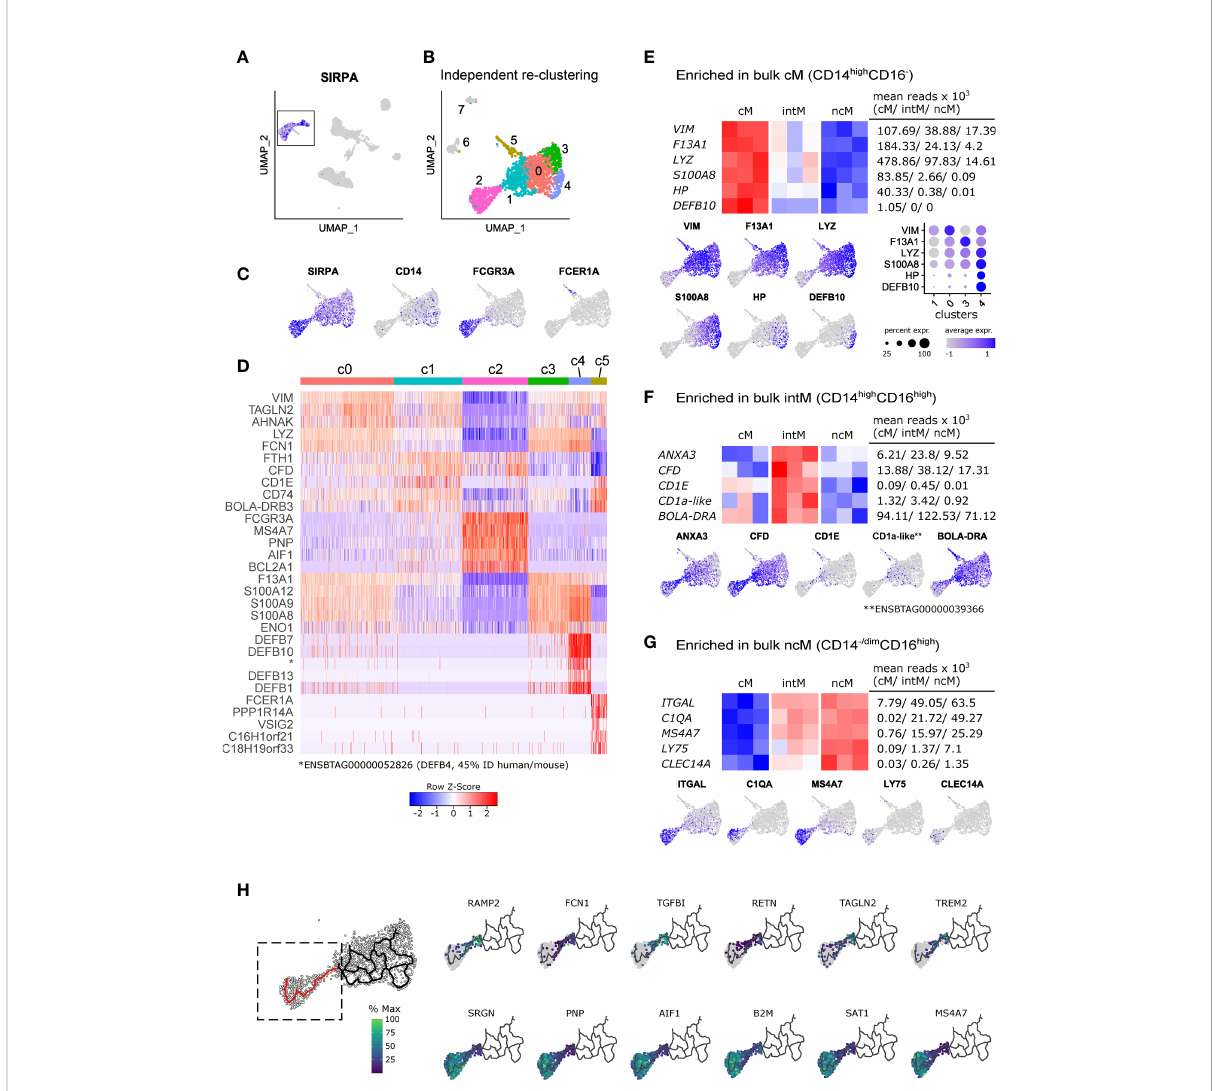
FIGURE 7 Single-cell RNA sequencing reveals heterogeneity of bovine monocytes. PBMC from two cows were subjected to 10x Genomics 3 ’ single-cell RNA sequencing. (A, B) Clusters containing SIRPA -expressing putative monocytes were subsetted for independent re-clustering. Clusters 6 and 7 were excluded from further analysis. (C) Feature plots show expression of SIRPA , CD14 , FCGR3A (CD16) and FCER1A in the re-clustered dataset. (D) Heatmap shows the top 5 (adjusted p-value) differentially expressed genes, revealing expression signatures resembling classical monocytes (c0, c3, c4), intermediate monocytes (c1, c2), nonclassical monocytes (c2), and cDC2 (c5). Differential expression testing was performed with seurat ’ s FindAllMarkers function. (E-G) Visualization of selected signature genes enriched in bulk-sequenced cM (E) , intM (F) , and ncM (G) . (H) Trajectory analysis on clusters 0-4 and visualization of genes differentially expressed along a selected trajectory (indicated in red). The complete list of differentially expressed genes along this trajectory is given in Supplementary File